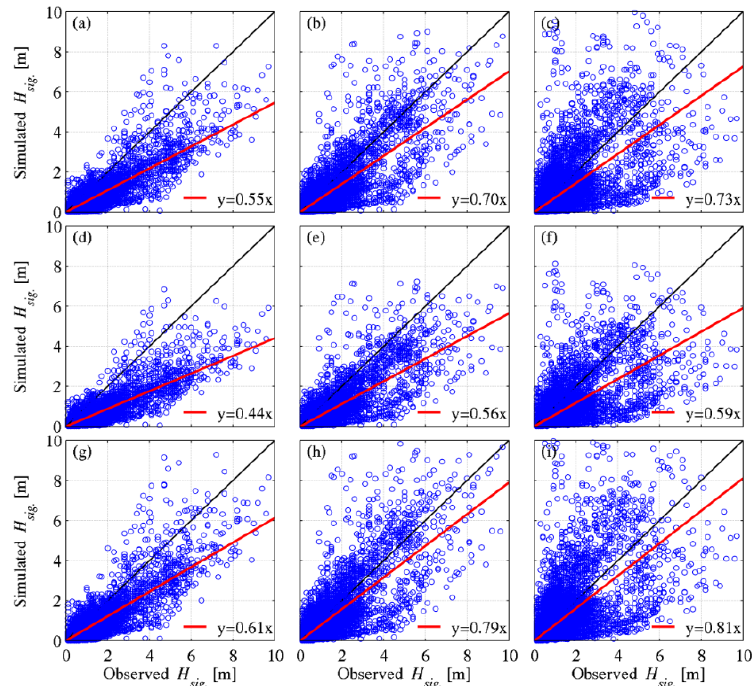
Figure 4. Comparison of the simulated and observed significant wave heights based on the experi- mental conditions of the numerical model. ( a ) Case00 (+00 h); ( b ) Case00 (+06 h); ( c ) Case00 (+12 h); ( d ) Case01 (+00 h); ( e ) Case01 (+06 h); ( f ) Case01 (+12 h); ( g ) Case02 (+00 h); ( h ) Case02 (+06 h); ( i ) Case02 (+12 h).